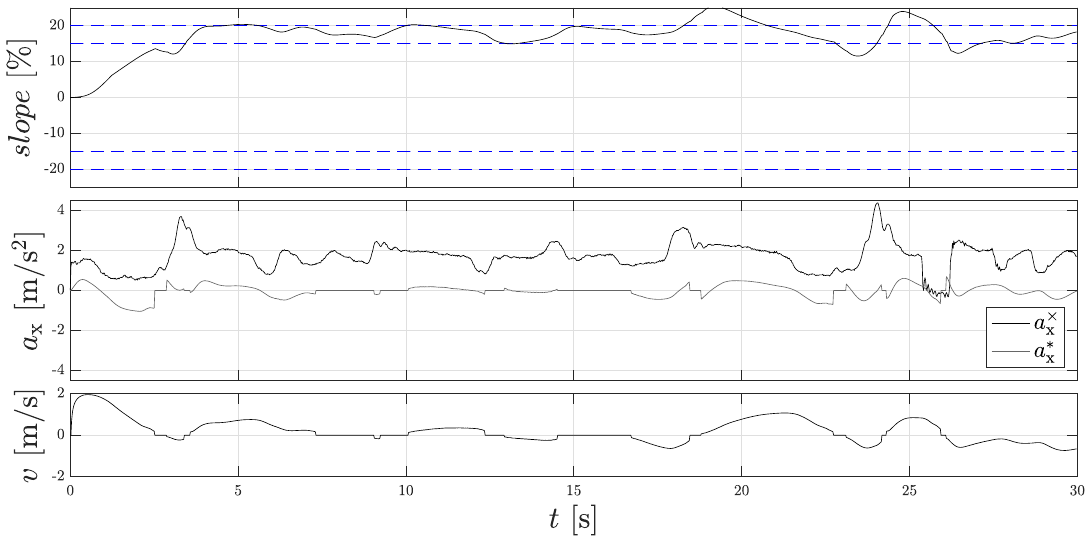
Figure 11. Slope estimation on the gradient hill during the measuring run with special driving style. ( Top ): Calculated slope slope ; ( Middle ): Measured acceleration of the IMU a ∗ x and acceleration of the filtered signal of the wheel speed sensors a ∗ x ; ( Bottom ): Vehicle velocity v